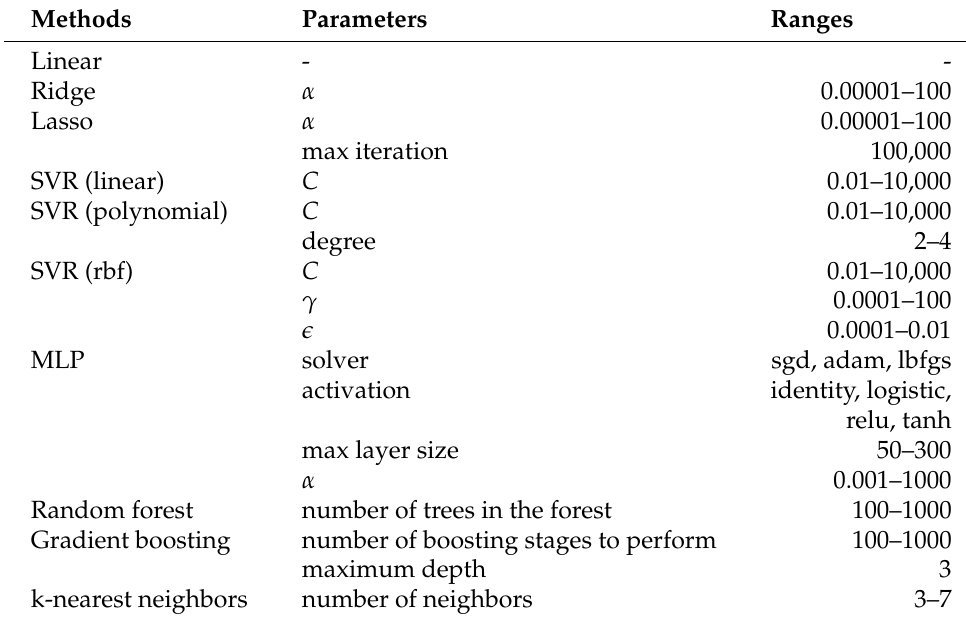
Table 2. Hyperparameters in each